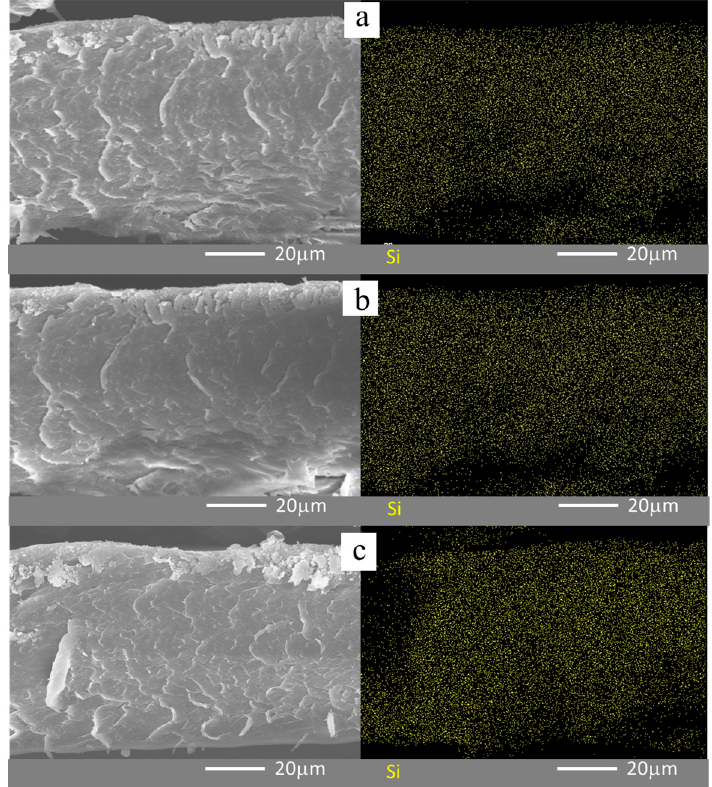
Figure 2. Cross-sectional SEM images and corresponding elemental maps of Si by an energy-dispersive X-ray spectrometer (EDS): ( a ) SiNF-Nafion-1% membrane; ( b ) SiNF-Nafion-3% membrane; and ( c ) SiNF-Nafion-5% membrane.